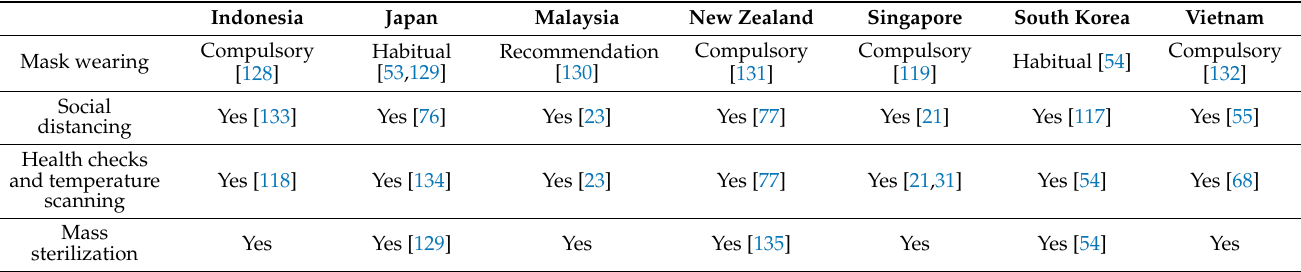
Table 14. SOPs in respective countries.